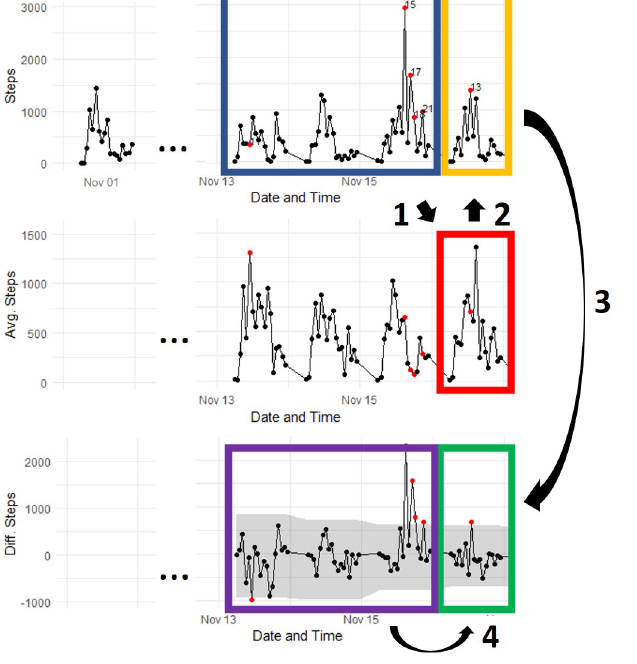
Figure 2. Illustration of first four steps of U-BEHAVED algorithm. Arrows and numbers represent algorithm steps and coloured boxes highlight relevant data of each step. X − axis represents date and time (in hours). Y − axis represents total number of steps (upper graph), mean number of steps using 3-day window (middle graph), and difference between present day and mean number of steps (lower graph). Black dots: data points; red dots: detected behaviour changes; and grey area: IQR.